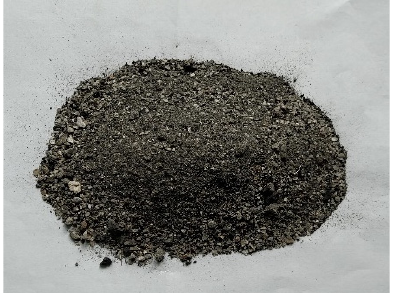
Figure 1. CFA. Figure 1. CFA.